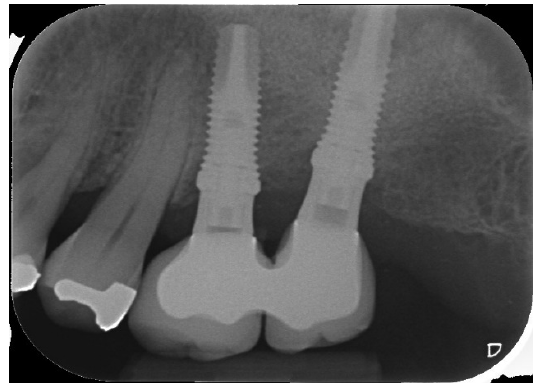
Figure 3. Radiographic control at 4 months.